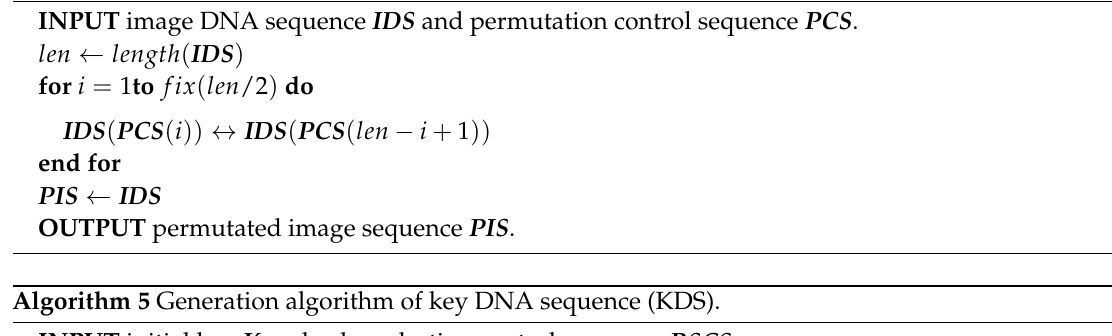
Algorithm 4 Permutation/Reverse permutation algorithm.